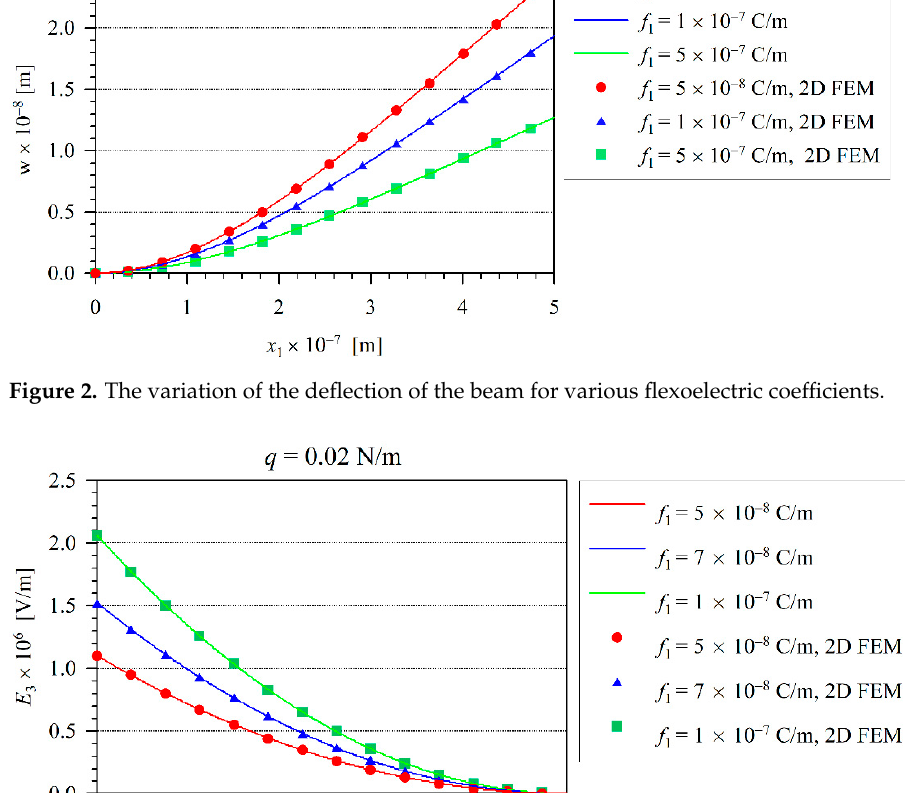
Figure 3. The distribution of the electric field E 3 along x 1 for a linear case.